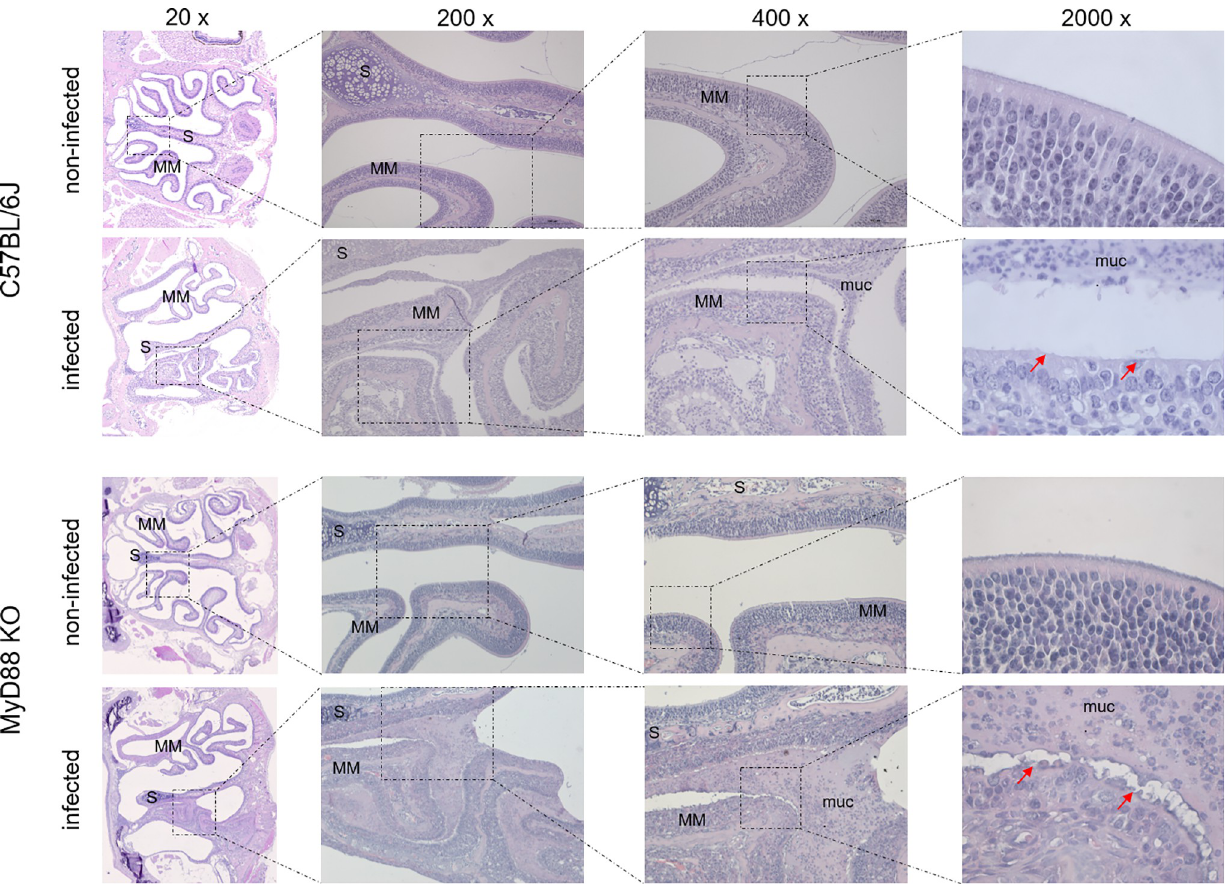
Fig 6. Details of B . pertussis -induced pathology in the nasal cavity of infected mice. Representative images of level 2 coronal sections through the nasal cavity of MyD88 KO and C57BL/6J mice on day 7 after inoculation of nares with 5 μ l of suspension containing 10 7 or 10 9 CFU of B . pertussis bacteria, respectively. Zoom-out of HE-stained sections at magnifications up to 2000x. The red arrows indicate the denuded infected mucosa lacking the ciliated columnar epithelial cells (lower panel), as compared to healthy ciliated columnar epithelial layer observed on the middle meatus (MM) and nasal septum (S) in the nasal cavity of non-infected animals (upper panel). The olfactory epithelium and the surface of intranasal septum in infected mice is covered with a thick layer of mucus (muc.), the cavity is filled with mucopurulent exudate and the turbinates of the infected animals exhibit slight atrophy. 3 mice per group were used and representative images of stained sections are